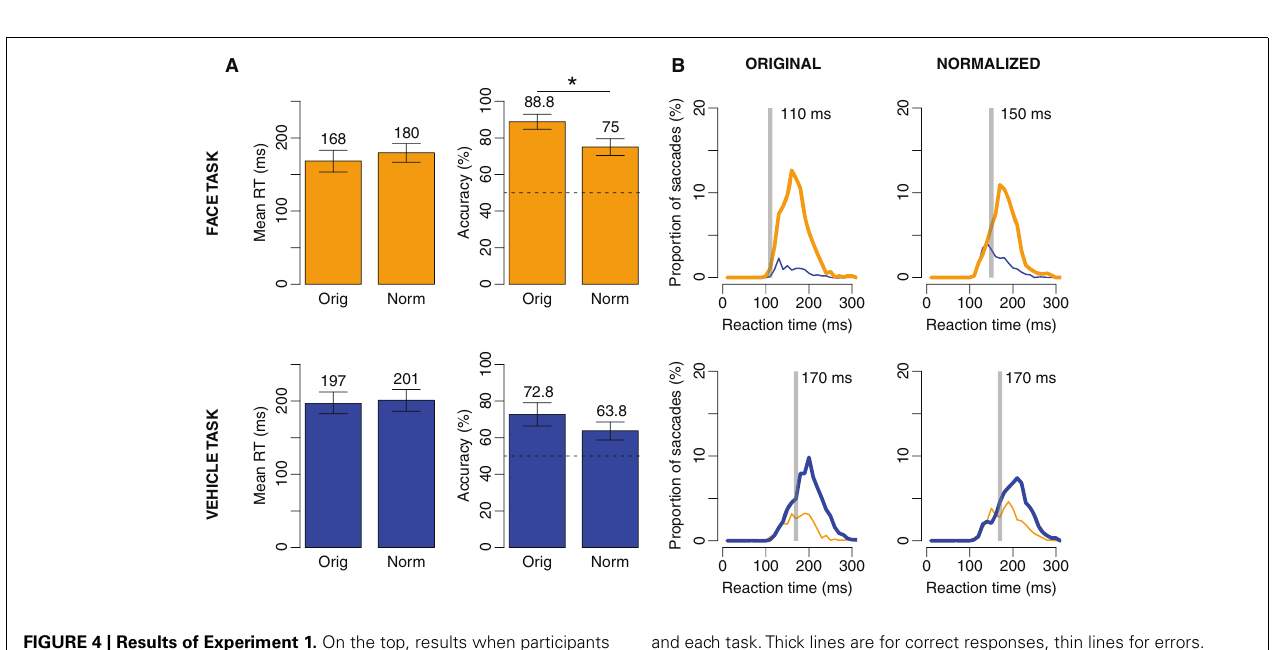
FIGURE 4 | Results of Experiment 1. On the top, results when participants had to saccade toward faces, on the bottom, results when participants had to saccade toward vehicles. (A) Mean RT and accuracy across subjects in the original (Orig) and normalized (Norm) conditions. Error bars represent bootstrapped 95% C. I. of the mean. (B) Distributions of RT in each condition